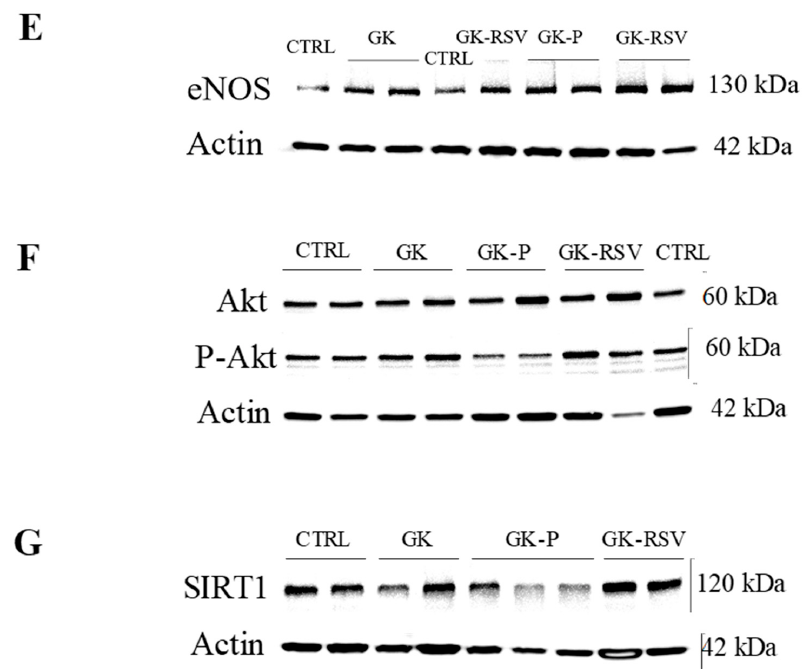
Figure 5. Protein expression of eNOS ( A ), Akt ( B ), PAkt (Ser 473) ( C ), and SIRT1 ( D ). Representative western blot of eNOS ( E ), Akt and its phosphorylated form ( F ), and SIRT1 ( G ). Data are expressed as means ± SEM and one-way ANOVA to compare the groups. * p < 0.05 vs. CTRL and GK-P; † p < 0.01 vs. GK; and ‡ p < 0.05 vs. CTRL, GK, and GK-P.